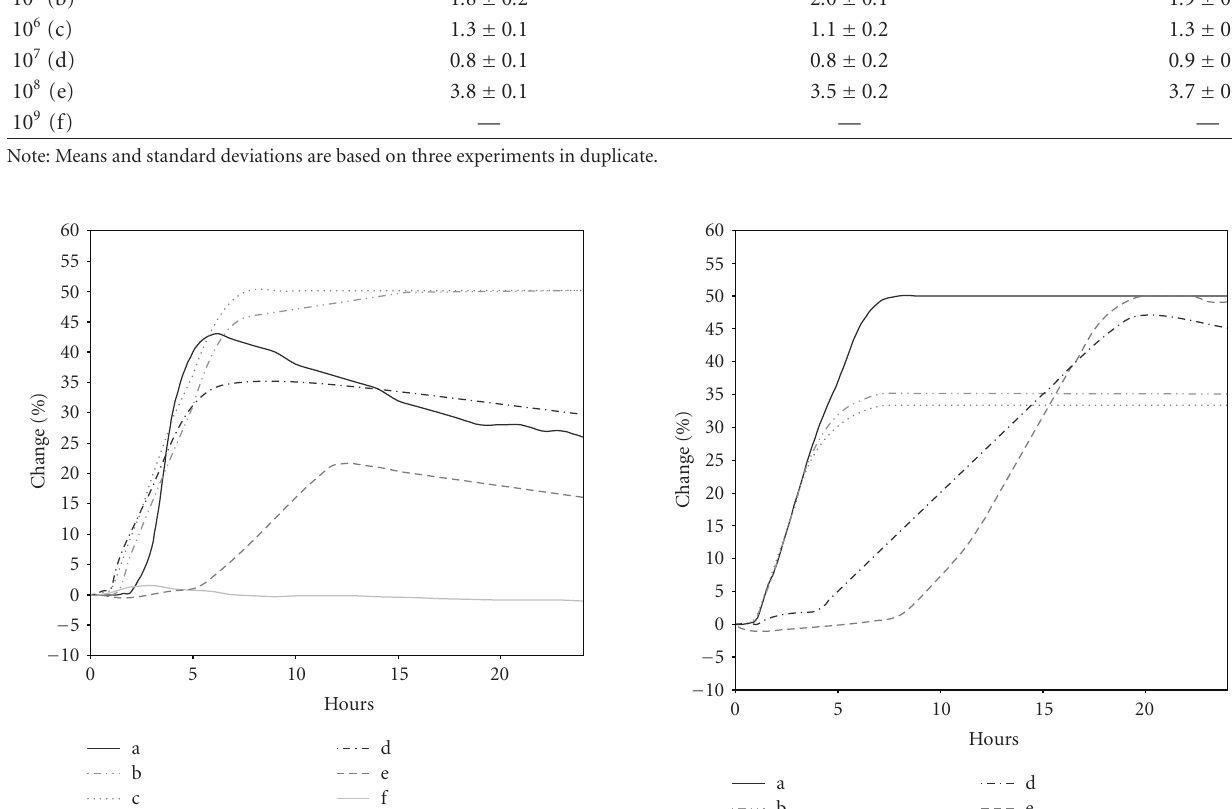
Figure 1: Detectable change in electrical characteristics checked at several bacteria densities. There were considered the mean values of duplicates from three experiments made for a representative phage (2/2) and its bacterial host (S1400/94): (a) 10 4 cfu/mL; (b) 10 5 cfu/mL; (c) 10 6 cfu/mL; (d) 10 7 cfu/mL; (e) 10 8 cfu/mL; (f) 10 9 cfu/mL.